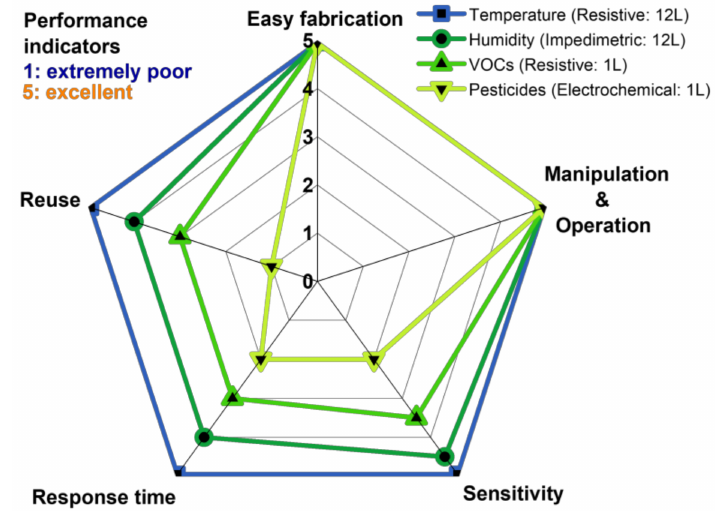
Figure 7. Spider diagram assessing the overall performance of PDAC/rGO- N L sensors for different applications presented in this